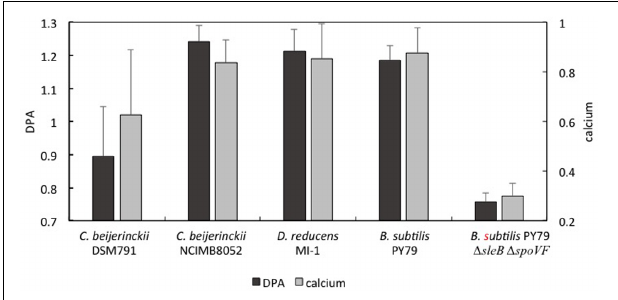
FIGURE 3 | Average values of dipicolinic acid (DPA) and calcium ions in scanning transmission x-ray microscopy (STXM) analyzed spores of several Clostridial species. All STXM data are normalized to the same thickness of the sample. The level of DPA is expressed as a ratio of the peak at 285.35 eV to the peak at 285.05 eV (black). Calcium is expressed as an absolute value of the peak at 352 eV (gray). Primary vertical axis correspond to DPA presence, secondary vertical axis correspond to calcium level (arbitrary